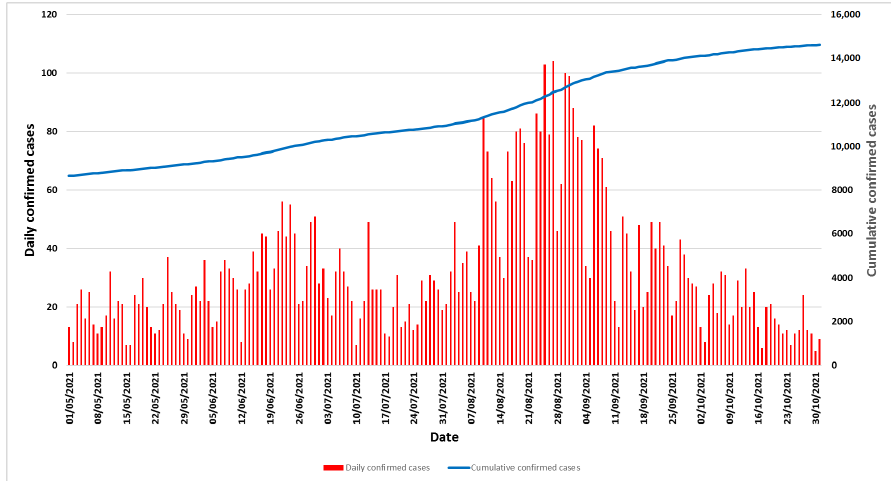
Figure 1. Confirmed cases of COVID-19 during the entire study